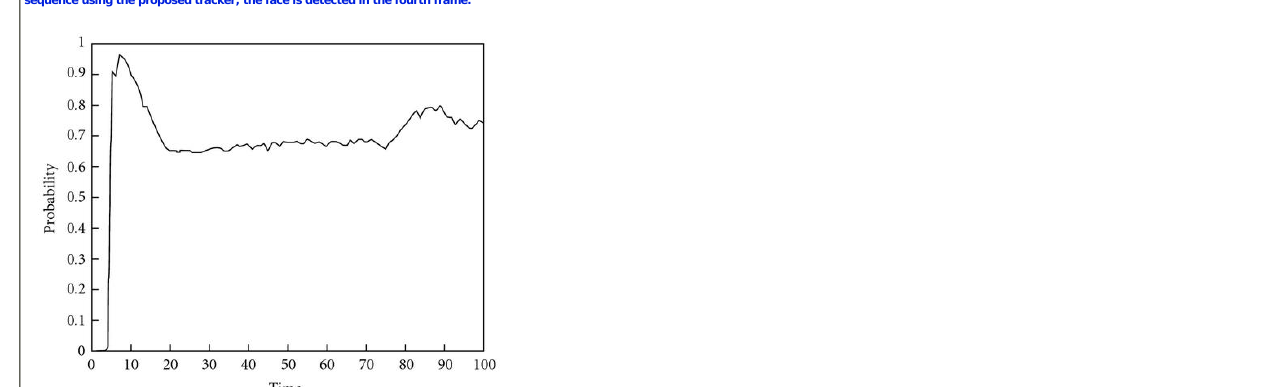
Figure 13 Estimated value of the a posteriori density of the face-center in a 100-frame sequence using the proposed tracker; the face is detected in the fourth